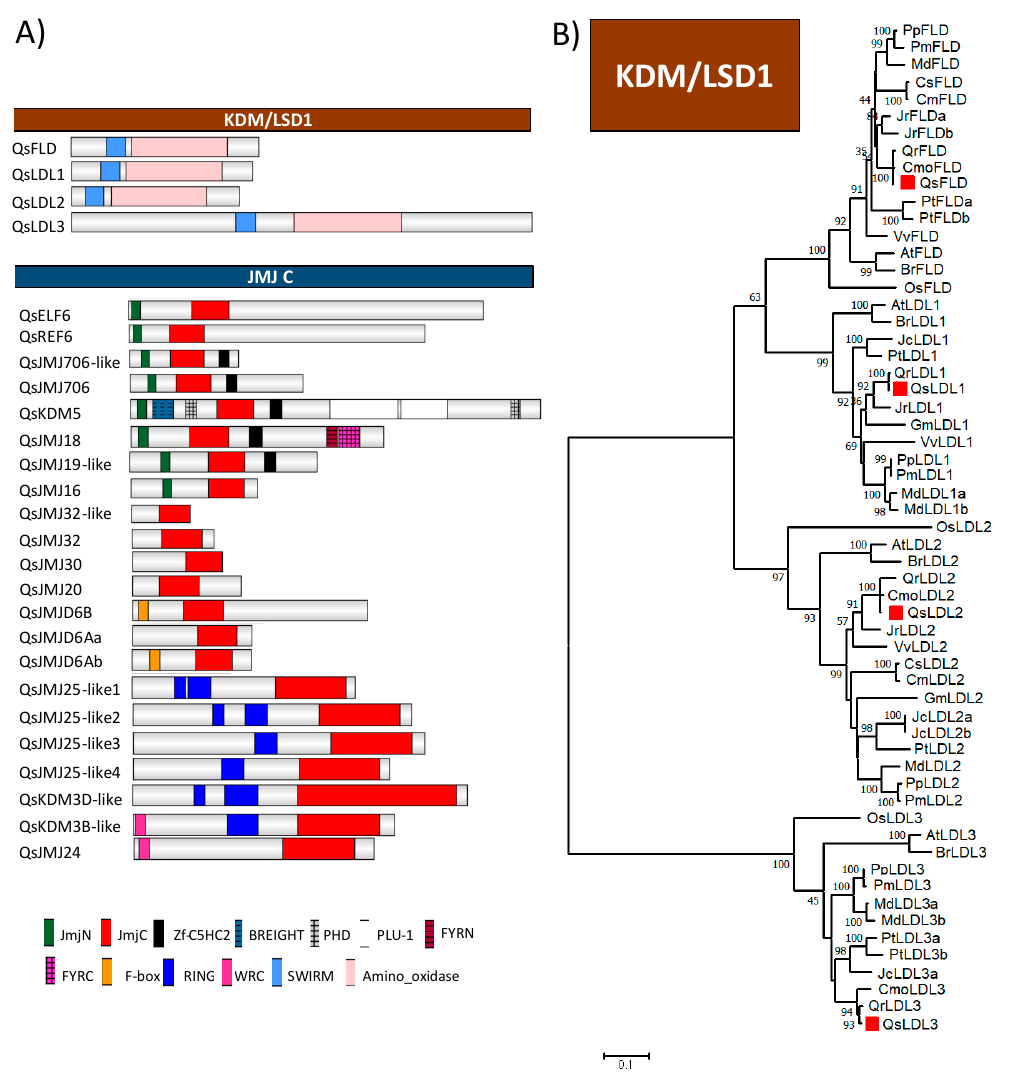
Figure 6. Quercus suber L. Histone Demethylases proteins with their ( A ) domain organization and ( B ) phylogeny of the KDM / LSD1 family. ( A ) Schematic diagrams show the domain organization of the enzymes. The proteins and the family they belong to are indicated on left side and above each corresponding schematic diagram, respectively. The di ff erent conserved protein domains are depicted in di ff erent colors as indicated in the legend at the bottom. RING-finger (IPR001841), WRC (PF08879) and JmjC (PF02373) are conserved domains of the KDM3 / JMJD1 class proteins. N-terminal JmjN (PF02375), JmjC, and the C-terminal C5HC2 (PF02928) domains are conserved typical of KDM4 / JMJD2 proteins. N-terminal F-box (PF00646), and C-terminal JmjC are conserved domains of the JMJD6 class. KDM / LSD1 proteins contain only the Amino oxidase (IPR002937) and SWIRM (IPR007526) domains. ( B ) The amino-oxidase and SWIRM domains of Quercus suber L. (Qs), Arabidopsis thaliana (L.) Heynh. (At), Brassica rapa L. (Br), Glycine max (L.) Merr. (Gm), Jatropha curcas L. (Jc), Populus trichocarpa Torr. & A.Gray ex Hook. (Pt), Prunus persica (L.) Batsch (Pp), Prunus mume (Siebold) Siebold & Zucc. (Pm), Vitis vinifera L. (Vv), Cucumis melo L. (Cm), Cucumis sativus L. (Cs), Juglans regia L. (Jr), Castanea mollissima Blume (Cmo), Quercus robur L. (Qr) and Oryza sativa L. (Os) were aligned using ClustalW and used to infer the evolutionary history using the Maximum-likelihood method. The evolutionary distances (left side scale bar) were computed using the Jones-Taylor-Thornton (JTT) correction model. The numbers at the nodes represent bootstrap values from 1000 replicates. The Q. suber proteins are indicated with a red square.